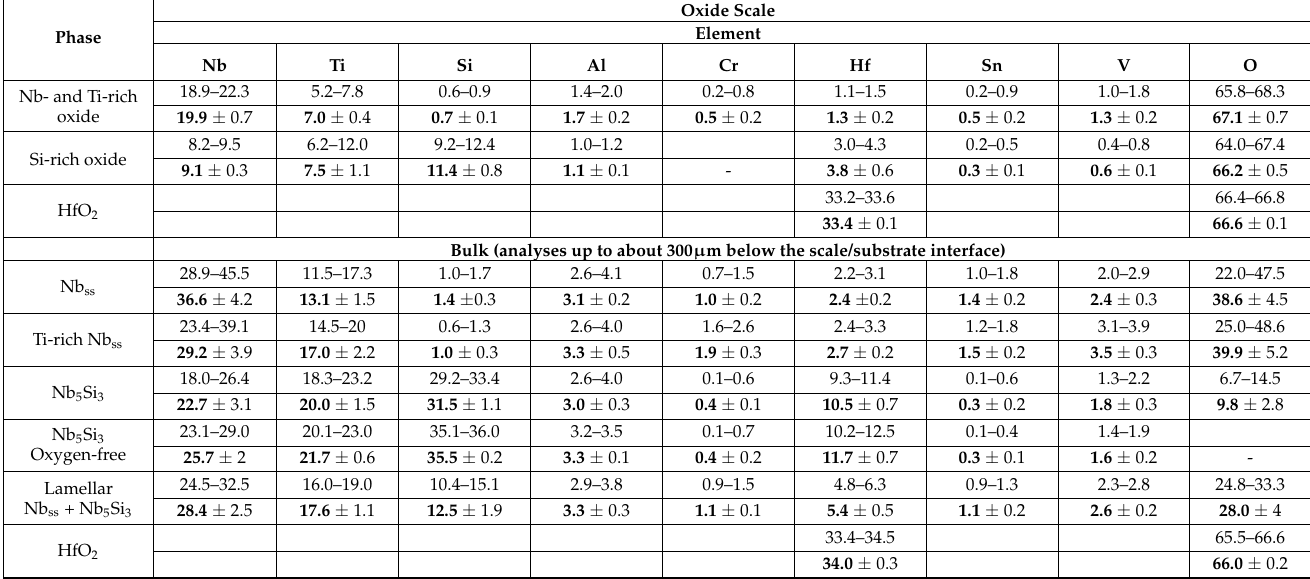
Figure 6. X-ray diffractogram of the oxides formed on NV1 after isothermal oxidation in static air at 900 °C for 100 h. Table 5. Chemical composition (at.%) of the phases present in the oxide scale and the bulk of the oxidised alloy NV1 at 800 ◦ C/100 h. (Average values are shown in bold